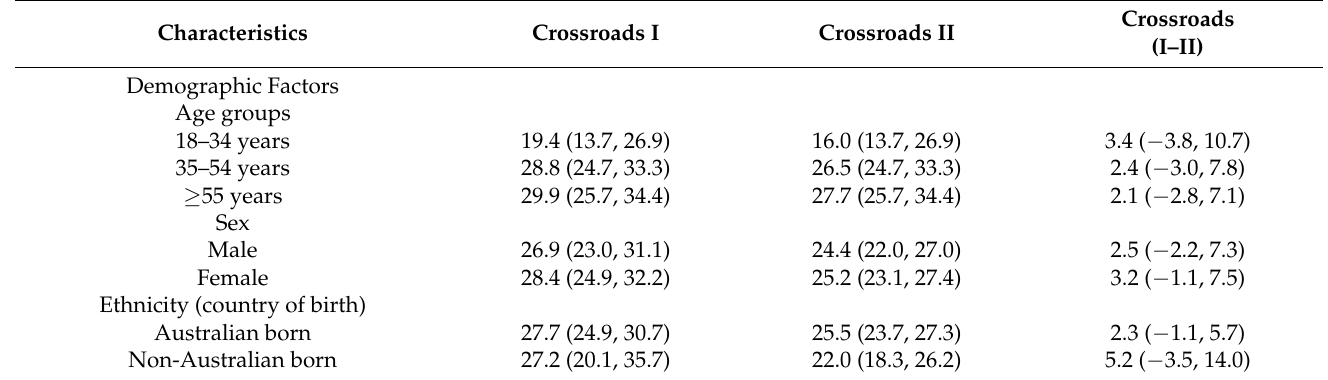
Table 2. Prevalence and differences as percentage-points of obesity prevalence by demographic, socio-economic, lifestyle and dietary characteristics in the Crossroads studies. Significant differences ( p < 0.05) are indicated as Asterix. TAFE = Technical and Further